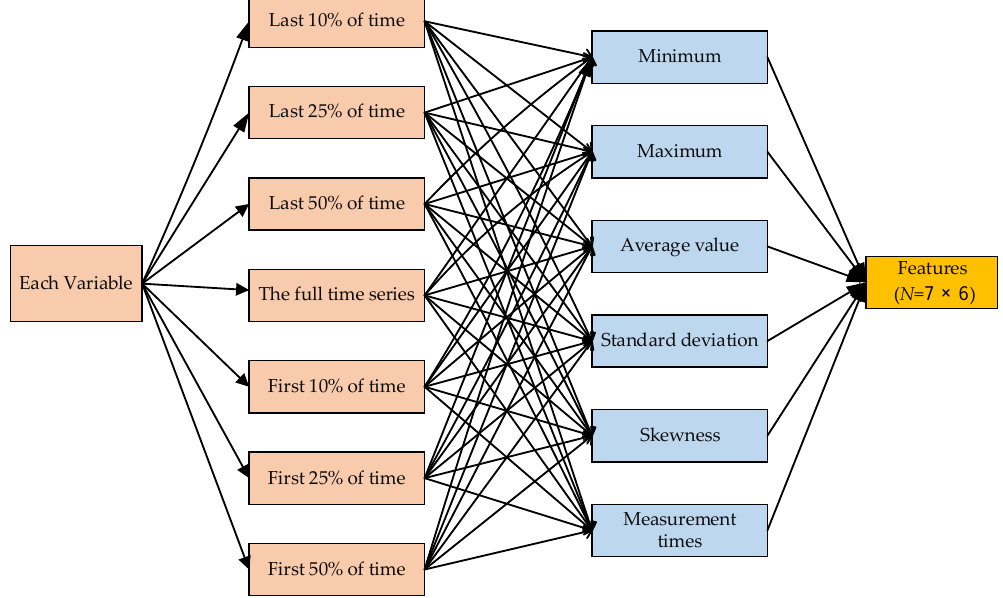
Figure 4. Feature extraction method in multinomial logistic regression.